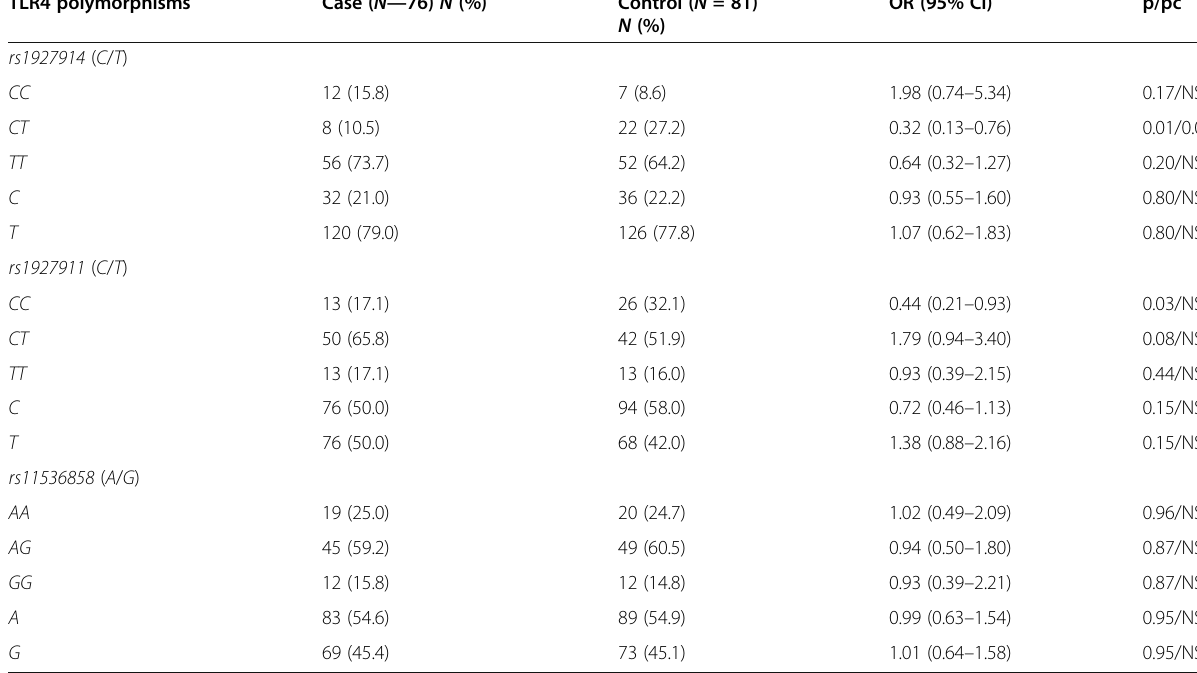
Table 4 Distribution of TLR4 alleles and genotypes vitiligo patients and healthy controls (group 2: above 18